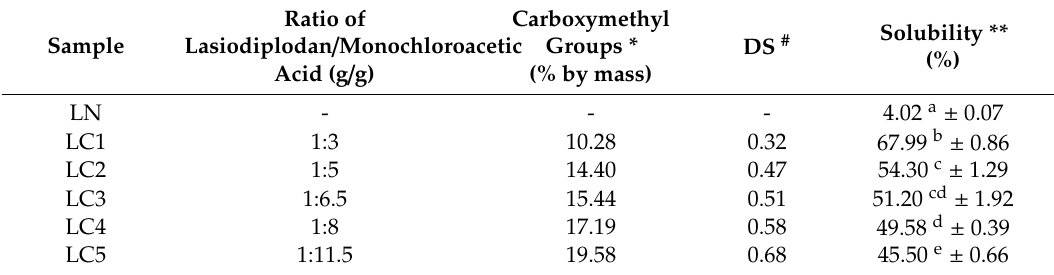
Table 1. Degree of substitution (DS) and solubility of LN and LC